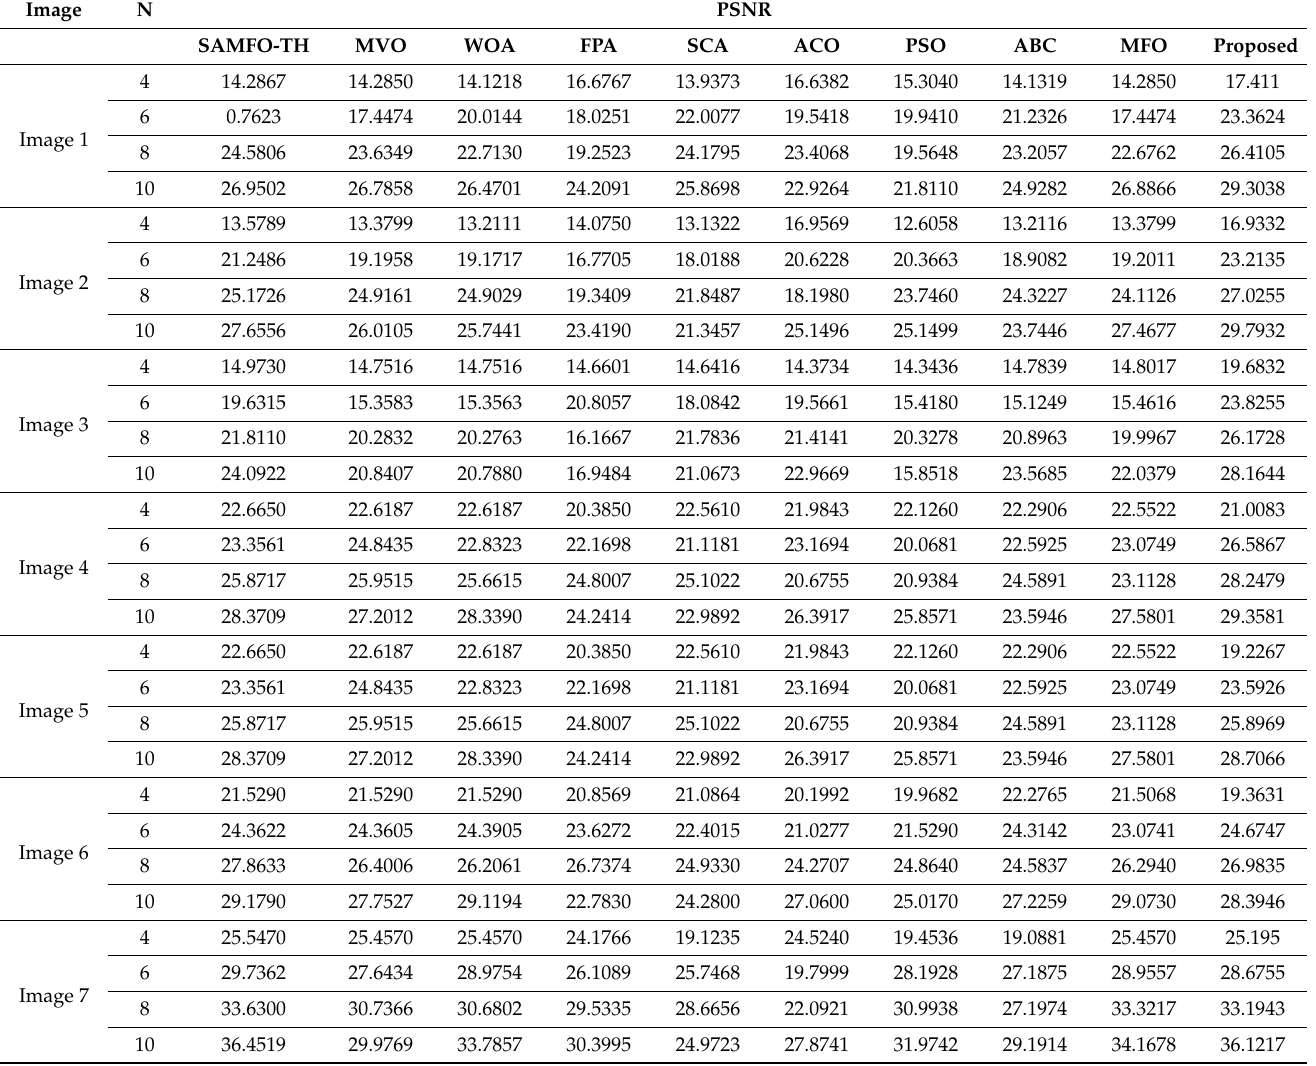
Table 2. Comparison of PSNR computed by SAMFO-TH, MVO, WOA, FPA, SCA, ACO, PSO,